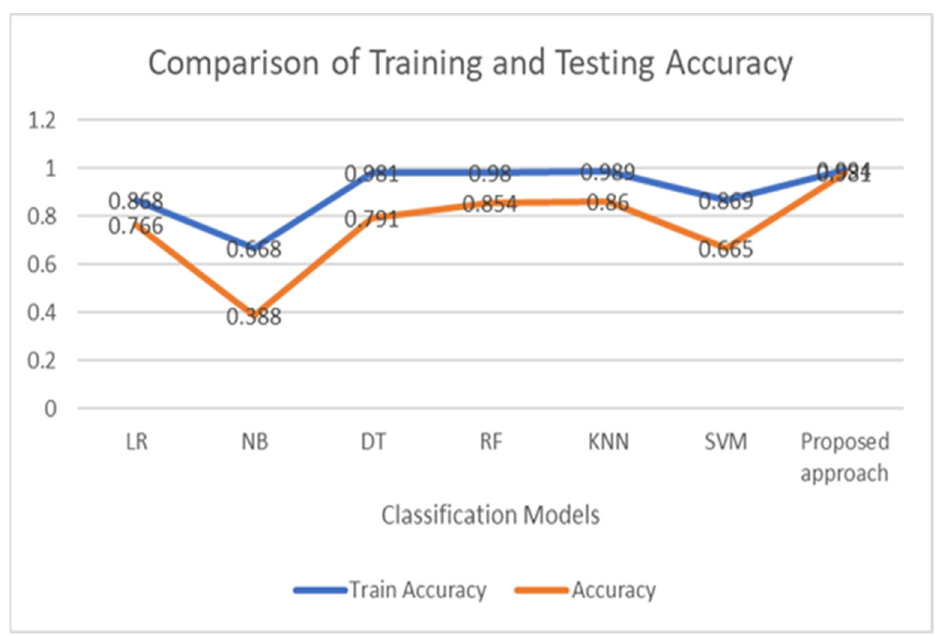
Figure 6. Comparison of training and testing accuracy.